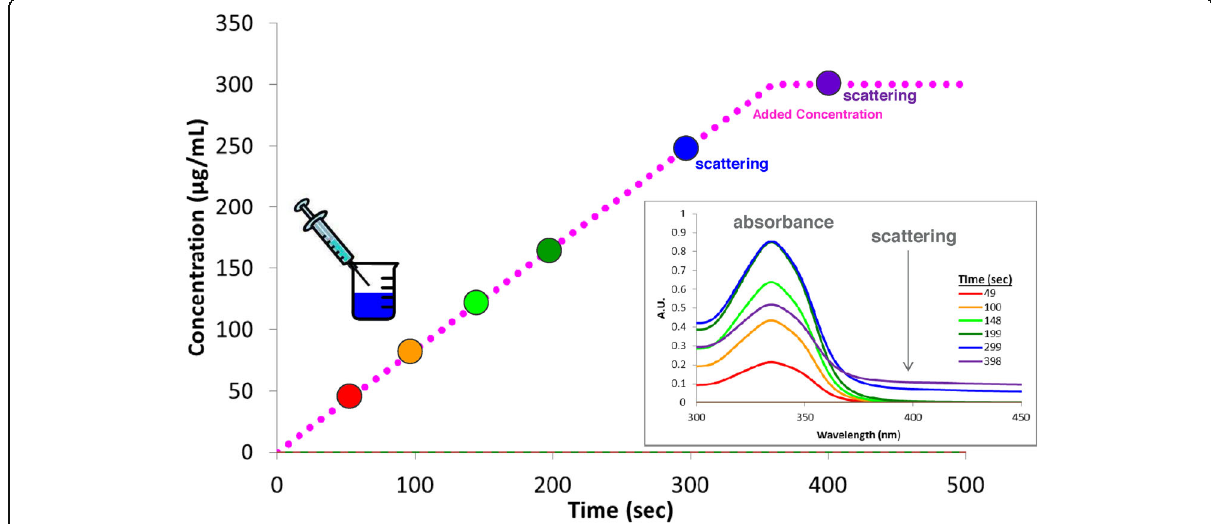
Fig. 7 Amorphous solubility determination (reproduced with permission from Capsugel)